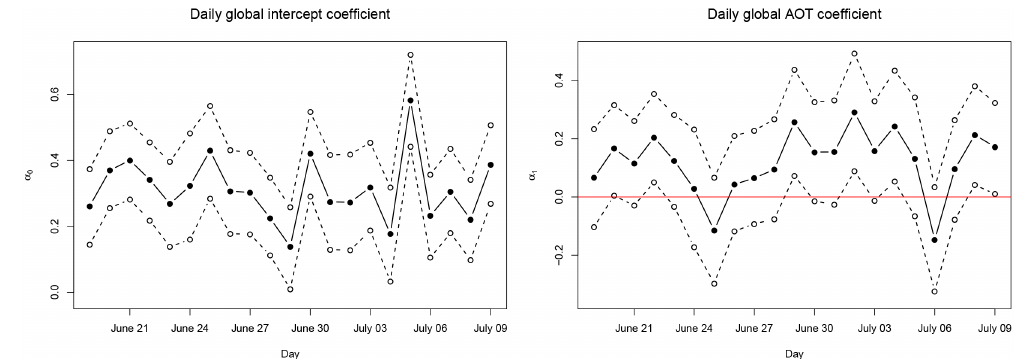
Figure 9. Mean and 90% credible interval by day for the (left) global intercept, α 0 , and (right) coefficient for AOT, α 1 , for Eq. (2).